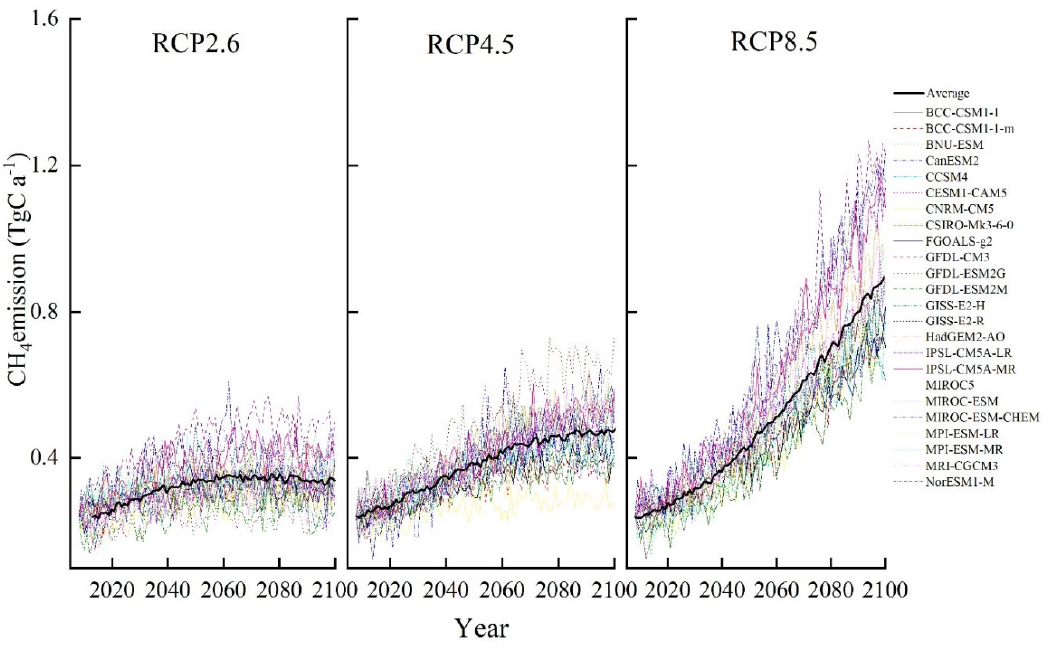
Figure 1. Variation in annual CH 4 emissions from wetlands on the Qinghai–Tibet Plateau during the period 2008–2100. CO 2 concentrations were assumed to rise up to 490–1370 × 10 − 6 by 2100. Results for the 24 CMIP5 models are shown, and the thick black line indicates the average across all models.